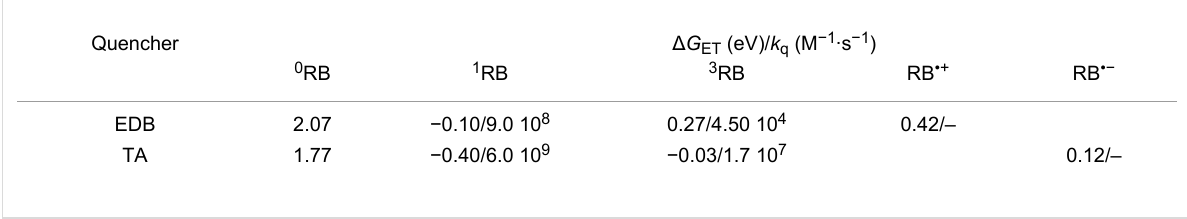
Table 2: Thermodynamic and kinetic parameters of the PCIS simulation, k q : quenching rate constant of excited states.